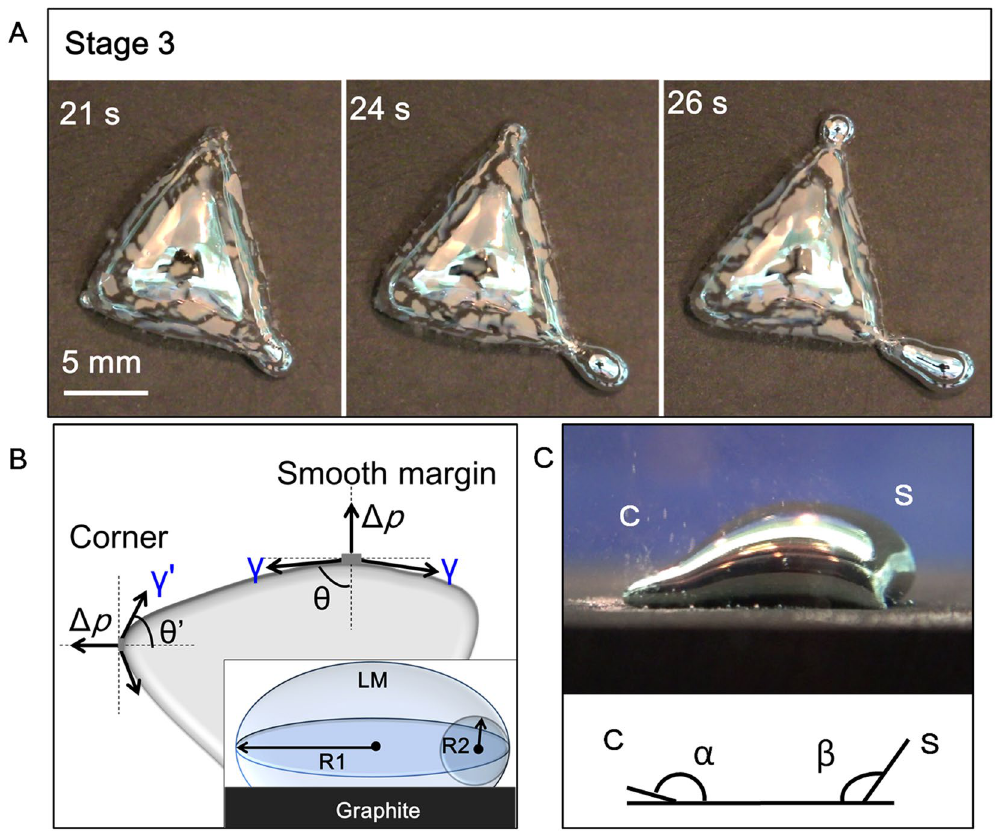
Figure 4. ( A ) The consecutive snapshots of the stretching out LM pseudopodia. ( B ) The force analysis indicates that the surface tension at the corner was lower than that at the smooth margin in the top view. The inset indicates the R1 and R2 in a LM droplet on graphite substrate in the horizontal view. ( C ) The side-view image of a LM-Al droplet with pseudopodia. C: Corner; S: Smooth margin. The contact angle at the corner ( α ) was observed smaller than that ( β ) at the smooth